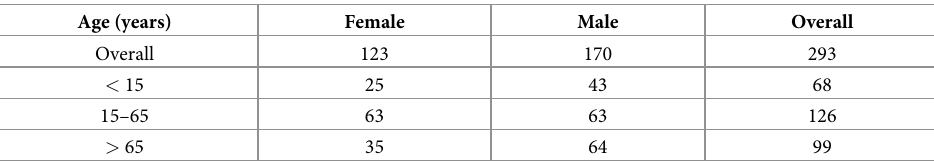
Table 1. Population